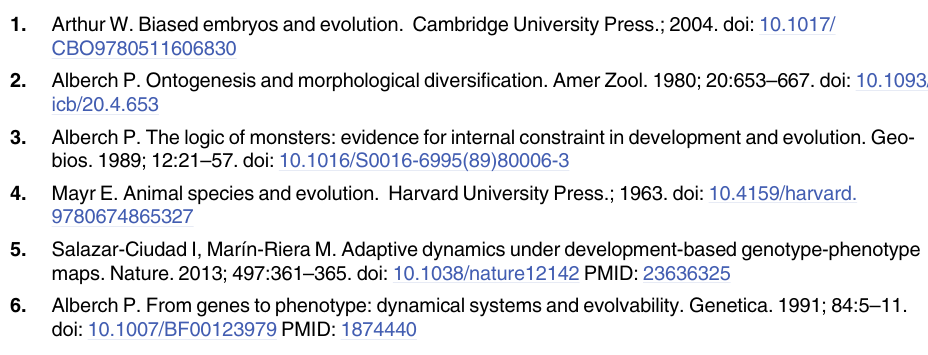
S4 Fig. Genotype space characterization. (PDF) S5 Fig. Minimum genome length depends on phenotypic complexity. S6 Fig. Phenotypic plasticity varies among phenotypes. S7 Fig. Phenotypic transitions probabilities calculated from random sampling and from evolving populations are highly